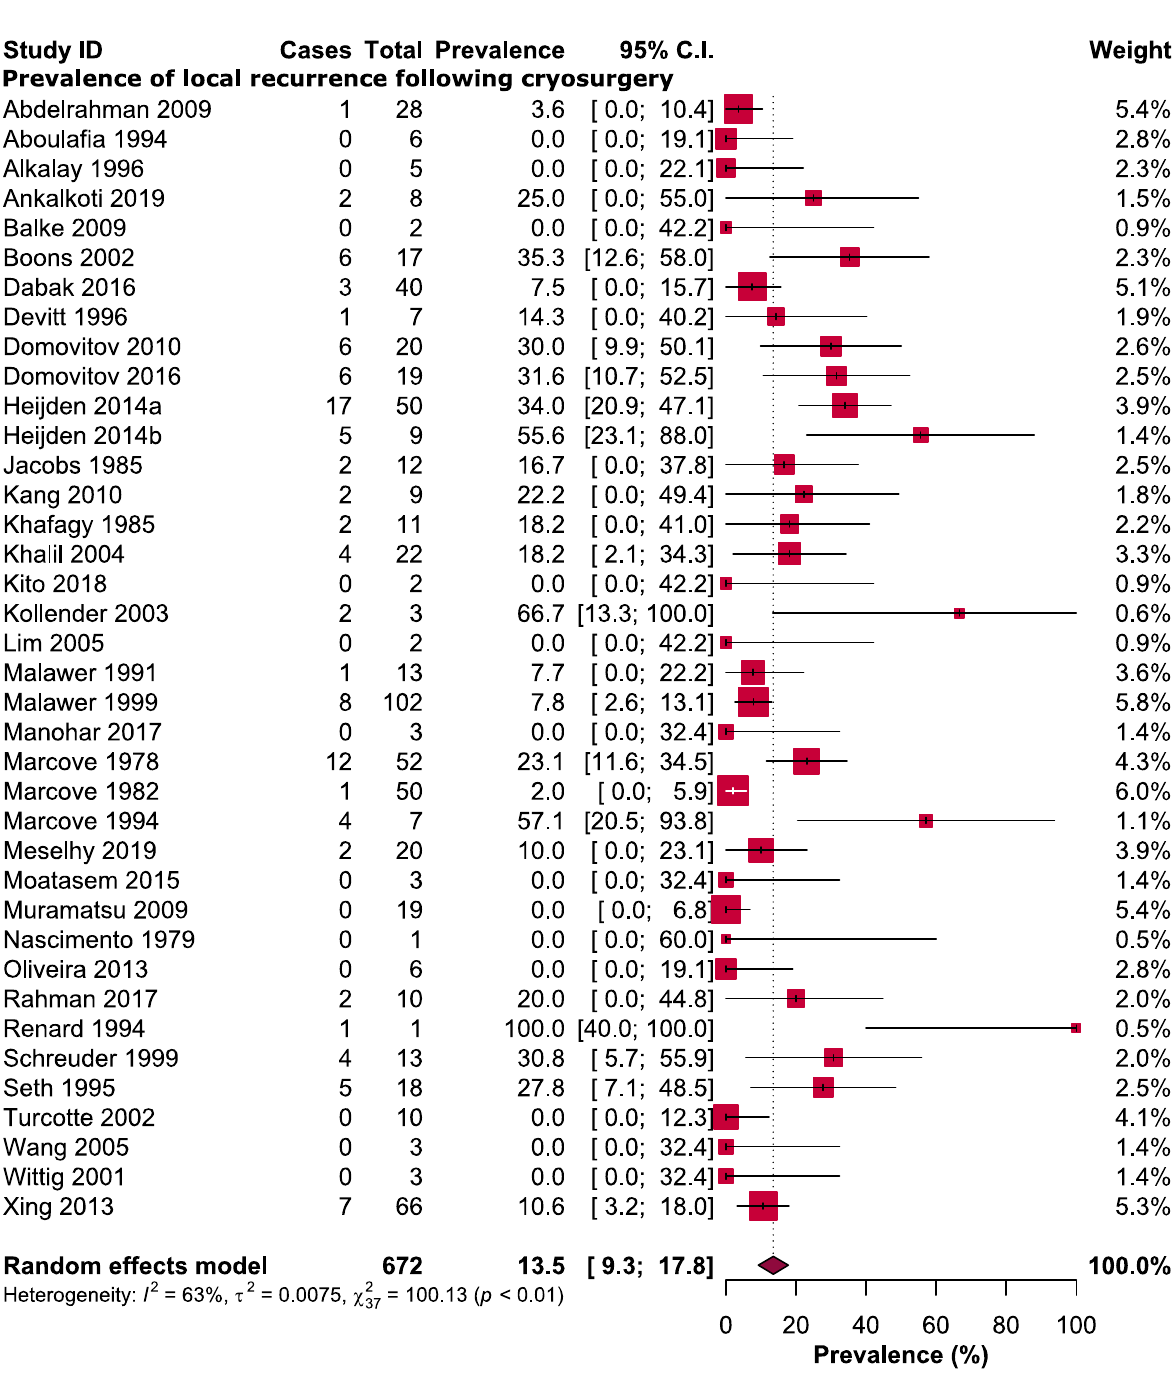
Figure 3. Prevalence of local recurrence following cryosurgery of giant cell tumour of bone. The main complications following cryosurgery in giant cell tumours that we identified were (i) fracture 3.9% (95% CI: 1.5–6.4, I 2 = 21%), (ii) infection 4.0% (95% CI: